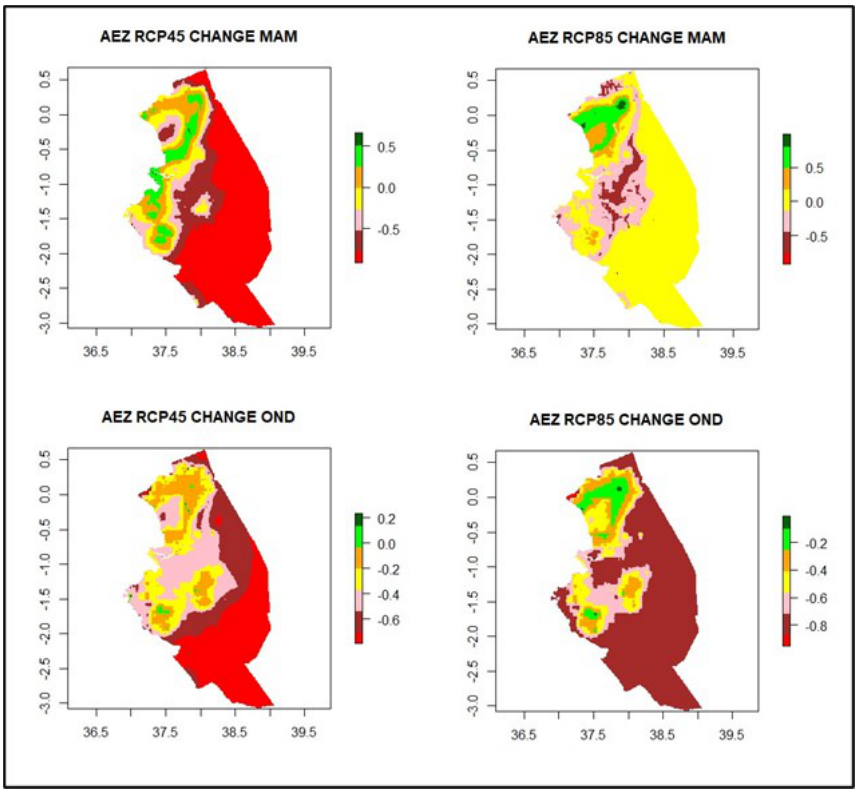
Figure 10. Agro-ecological zones and change maps from a 2020 baseline and RCP 4.5 2040.